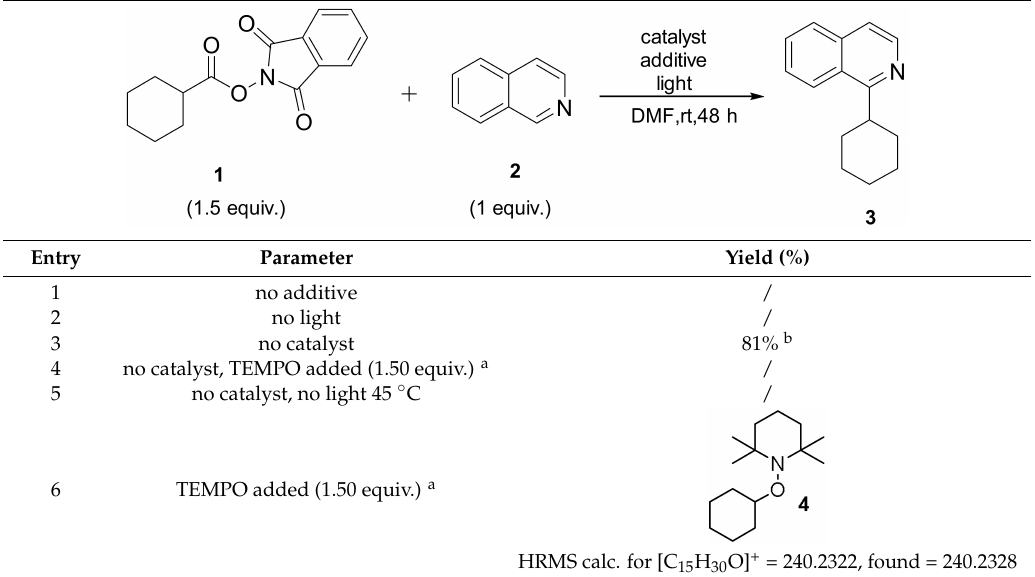
Table 2. Control